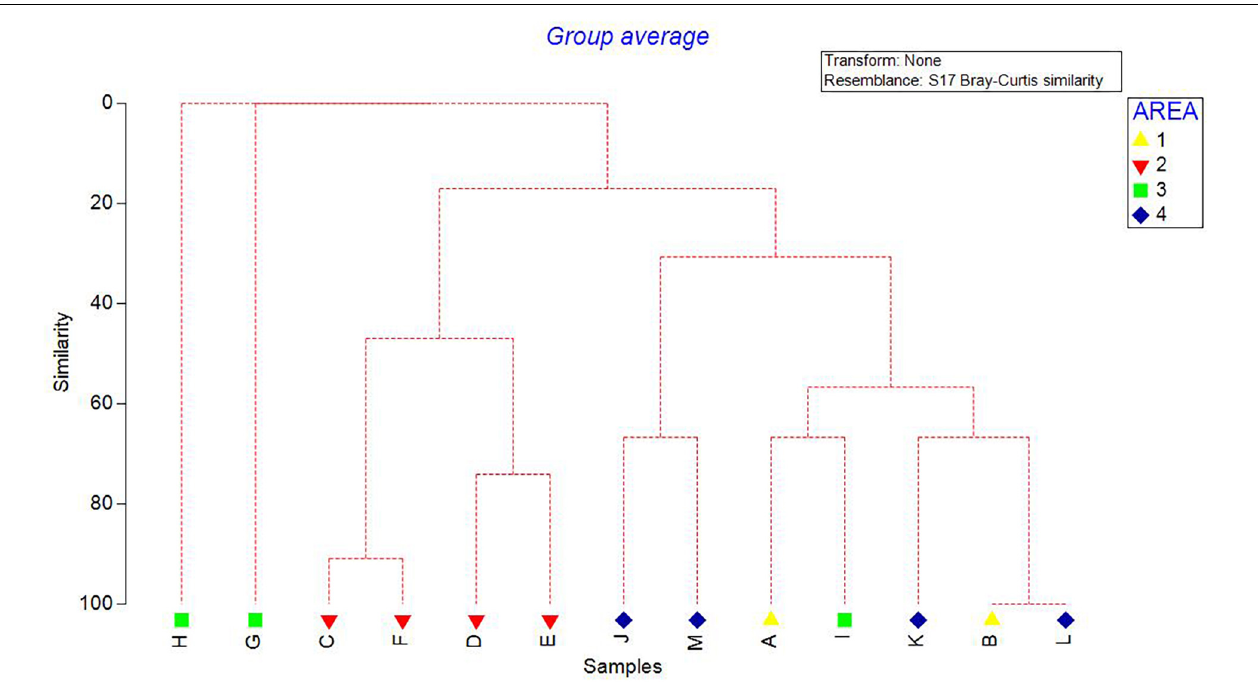
FIGURE 7 | Dendrogram showing the clustering of transects/areas (Area 1, Area 2, Area 3, and Area 4). Analysis was based on the density values (individuals/m 2 ) of sponge morphotype